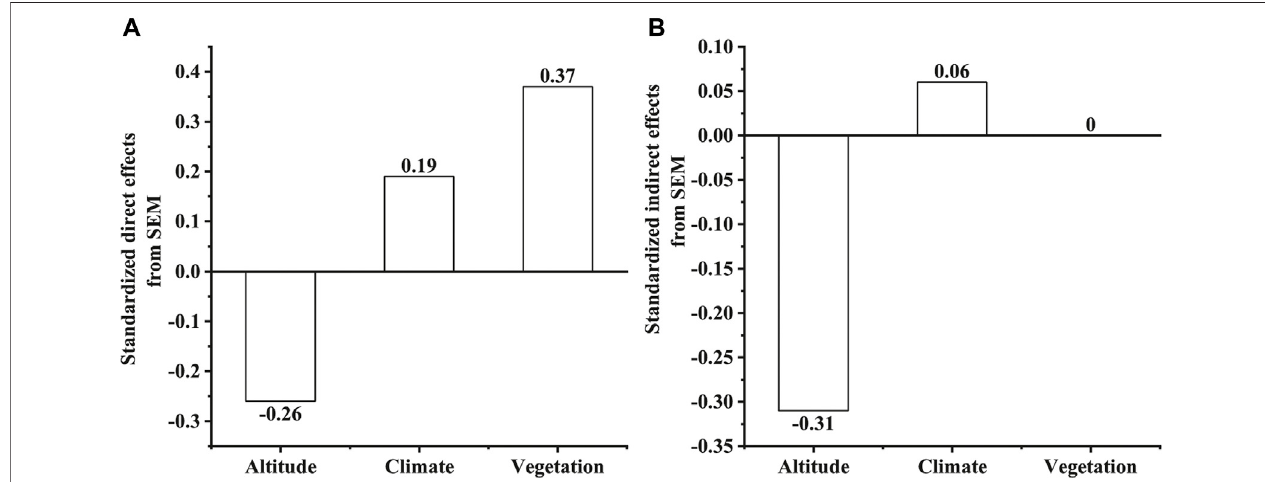
FIGURE 5 | Standardized effects of each variable from the PLS-PM. (A) and (B) represent the standardized direct and indirect effects of altitude, climate, and vegetation, respectively. The values adjacent to the column represent the standardized coef fi cients in PLS-PM.